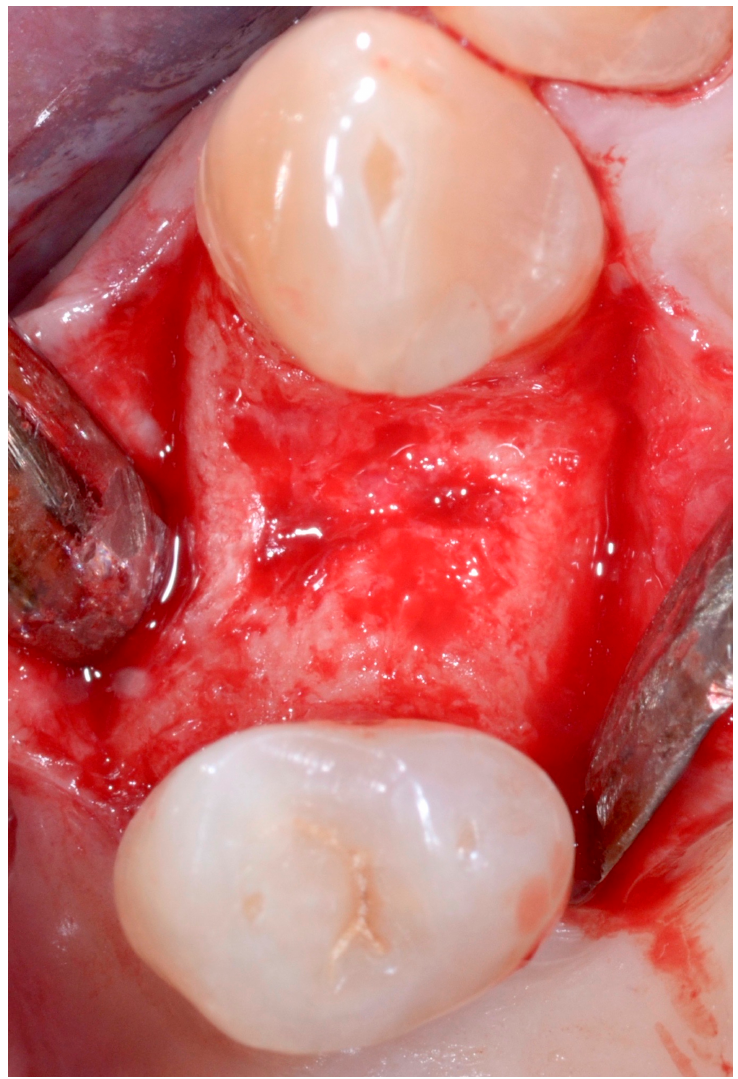
Figure 7. Alveolar ridge at surgical re-entry four months after tooth extraction.